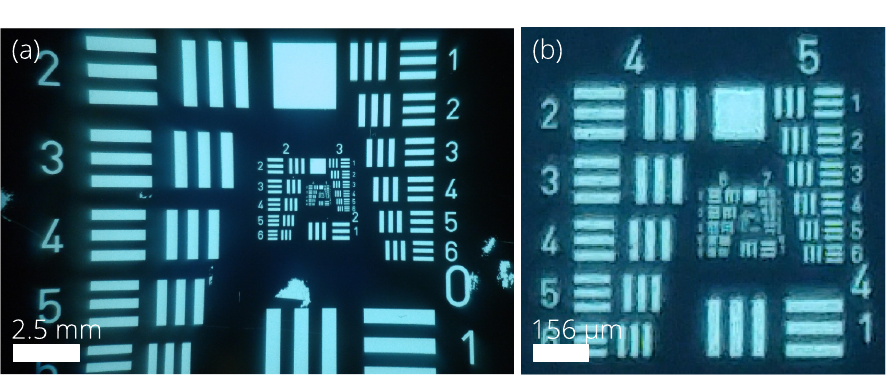
Fig 9. Image of a 1951 USAF resolution test chart showing the (a) full field of view of the intraoral probe and (b) contrast limit. The zoomed contrast limit image (b) shows group 6–2 is resolvable, a cutoff frequency of 71.8 lp/mm.